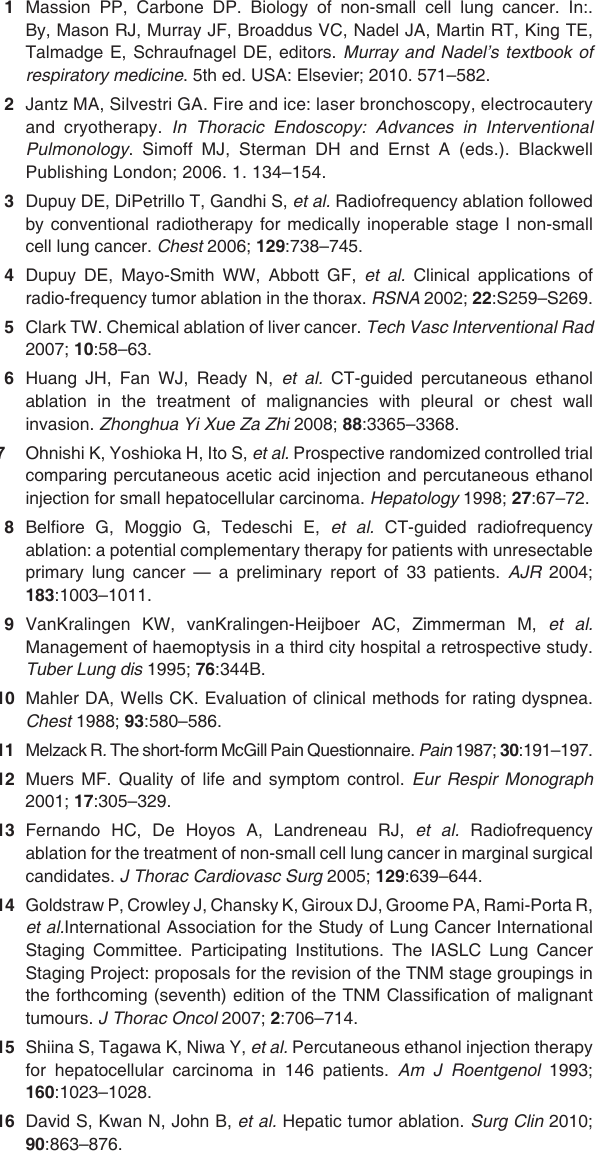
Table 3 Radiological response in the tumor mass after 3 and 6 months of treatment measured with computed tomography of the chest (modified RECIST criteria) [13]